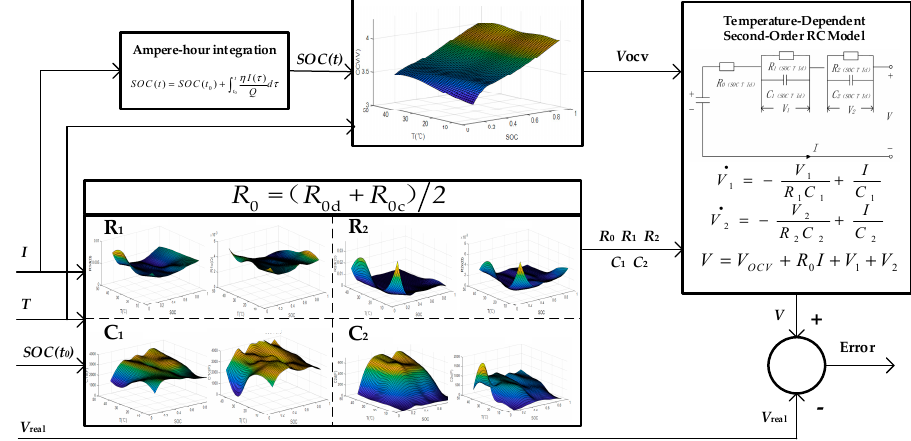
Figure 8. Schematic of the simulation model.